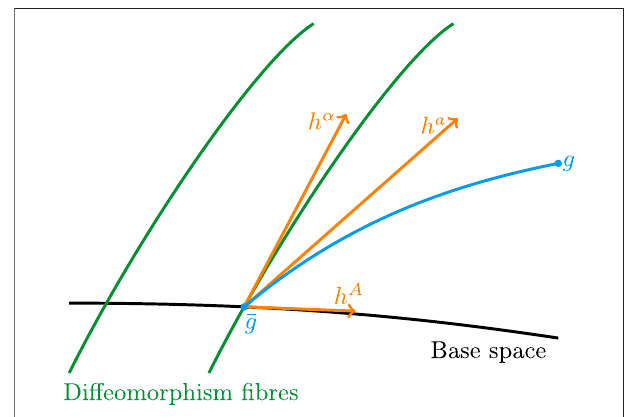
FIGURE 1 | Illustration of the con fi guration space of metrics with the Vilkovisky connection. The background metric g and the full metric g are connected by geodesics. The fl uctuation fi eld h a is a tangent vector of these geodesics at the background metric. h A is the projection on the base space, while h α is the projection on the diffeomorphism fi ber. The effective action depends only on h A and not on h α